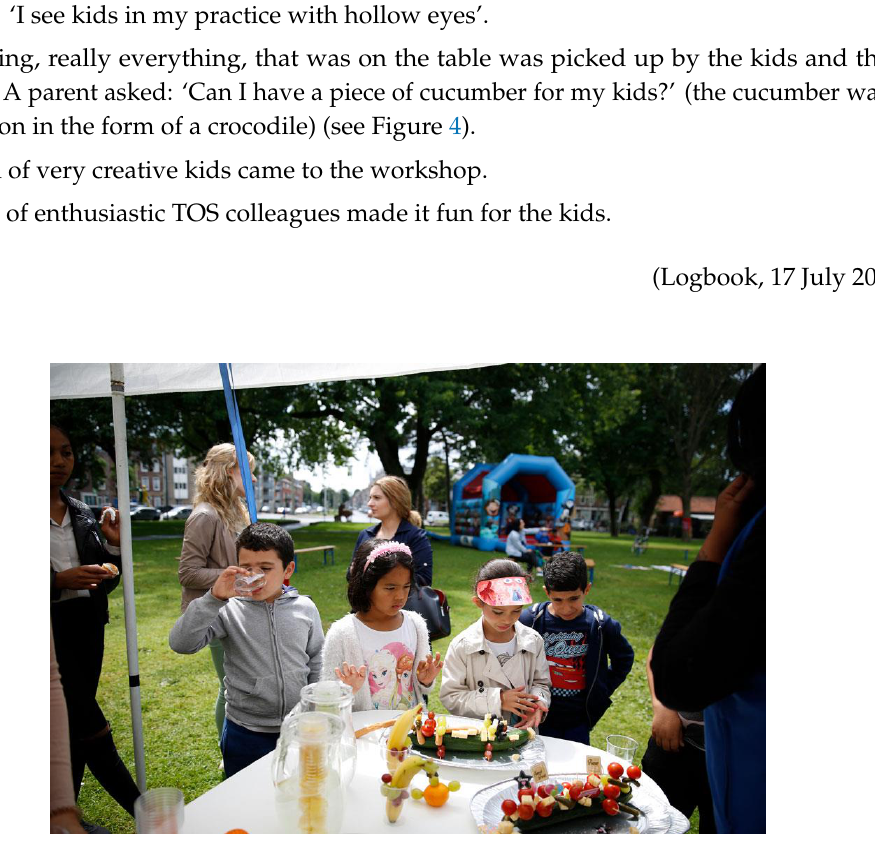
Figure 4. Eagerness to taste healthy treats at the Beach week.